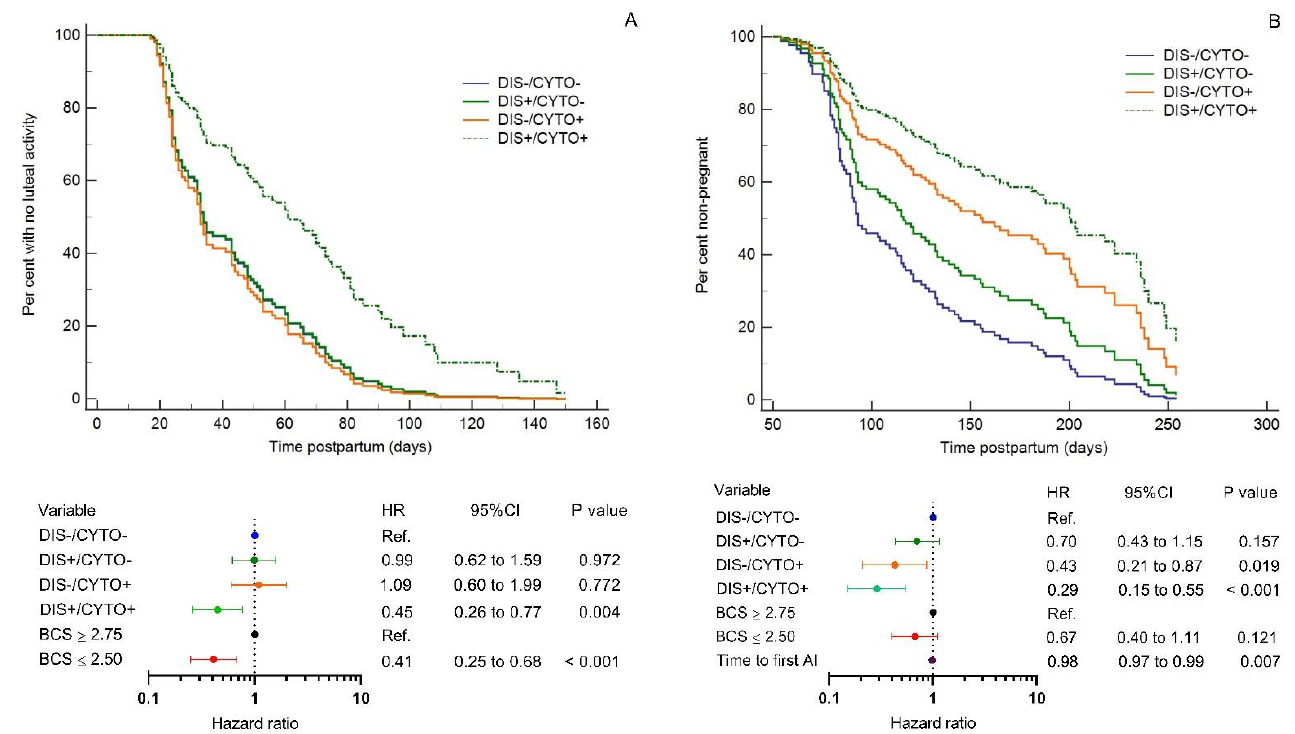
Multivariate Cox’s proportional hazard curves and adjusted hazard ratios (HR) with 95% confidence intervals (CI) for time to onset of luteal activity ( n = 119) ( A ) and time to pregnancy ( n = 112) ( B ) for multiparous Holstein cows stratified by disease (DIS) and cytological endometritis (CYTO) statuses (DIS − /CYTO − = disease-negative/CYTO-negative; DIS+/CYTO − = disease-posi- tive/CYTO-negative; DIS − /CYTO+ = disease-negative/CYTO-positive; DIS+/CYTO+ = disease-posi- tive/CYTO-positive). Time to onset of luteal activity was adjusted for body condition score (BCS) at week +3 postpartum (≥2.75 and ≤2.5). Onset of postpartum luteal activity was defined as the first milk progesterone rise above 5 ng/mL. Time to pregnancy was adjusted for time to first artificial insemin ation (AI) and BCS at week +3 postpartum (≥2.75 and ≤2.5). HR < 1 indicates a reduced daily relative risk; HR > 1 indicates an increased daily relative risk.